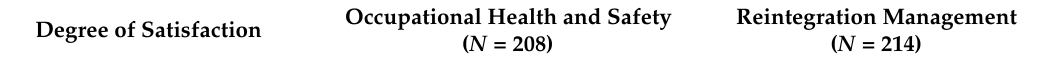
Table 6. Satisfaction with implementation status in the domains ‘occupational health and safety’ and ‘reintegration management’ according to compliance with legal requirements in a given domain.